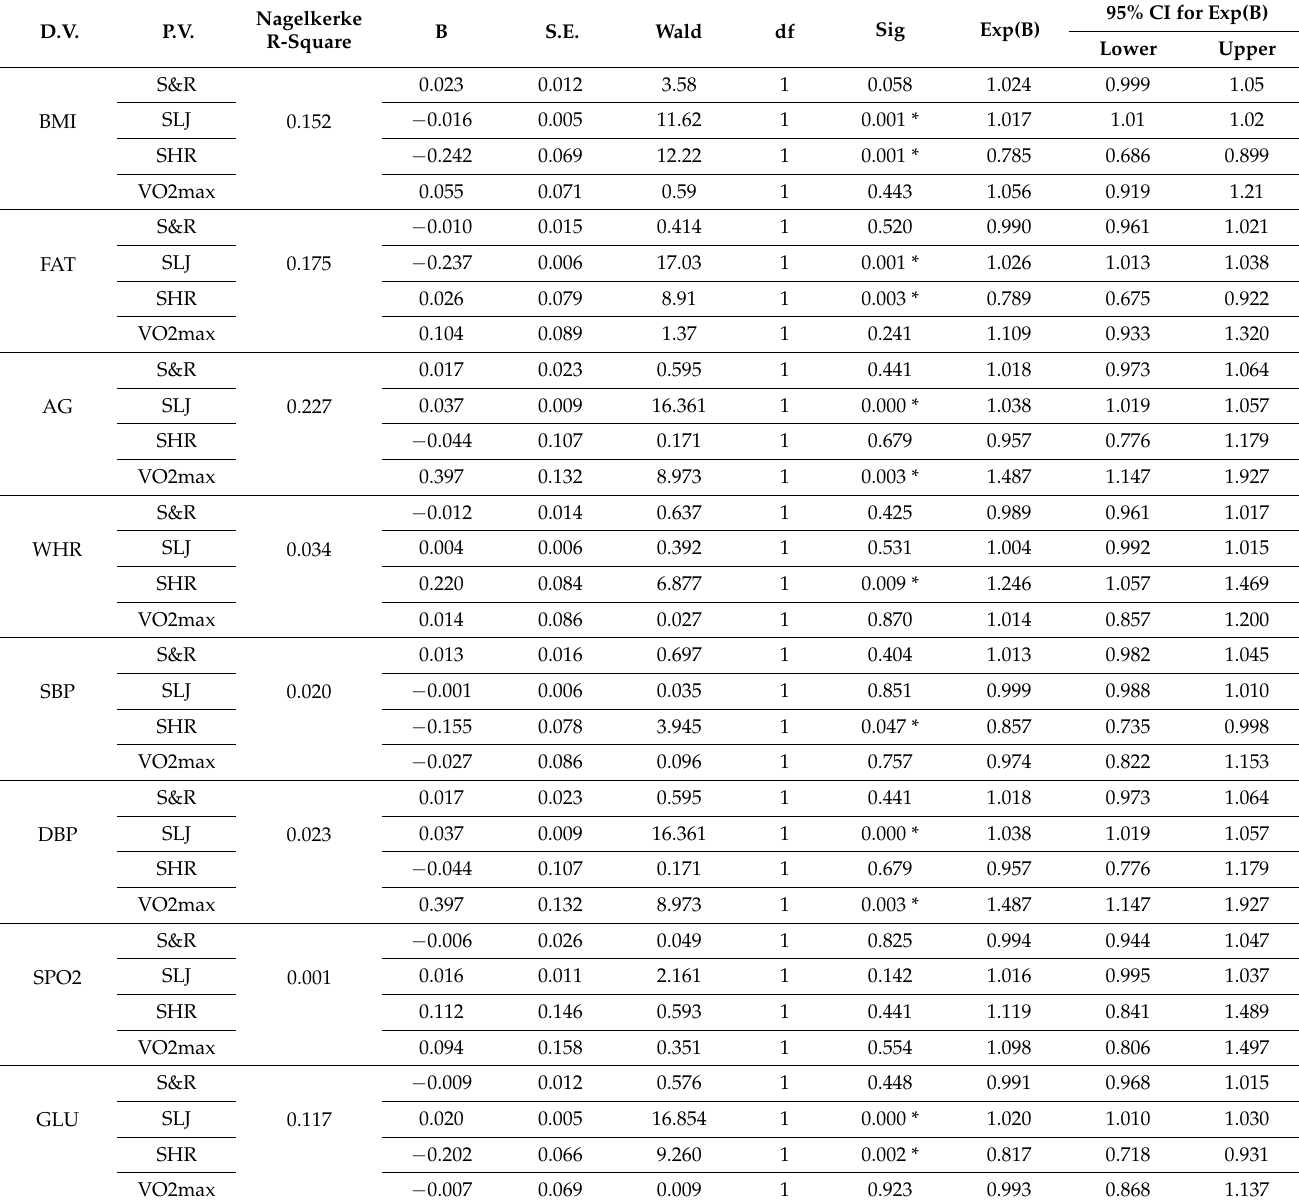
Table 5. Logistic regression analysis to verify the fitness test results’ predictive ability for the following variables: BMI, FAT, AG, WHR, SBP, DBP, SPO2, and